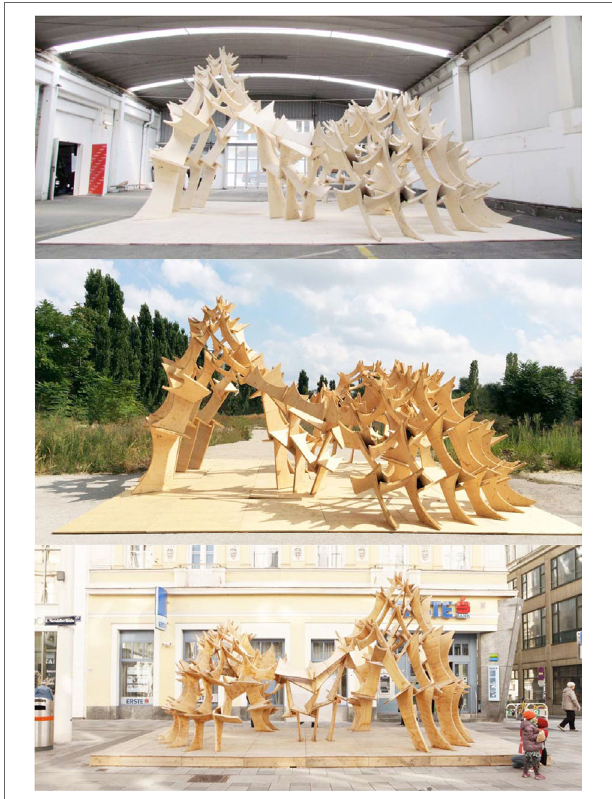
FIgURe 1 | DigDesFab15 “noHOME” research pavilion at multiple locations.